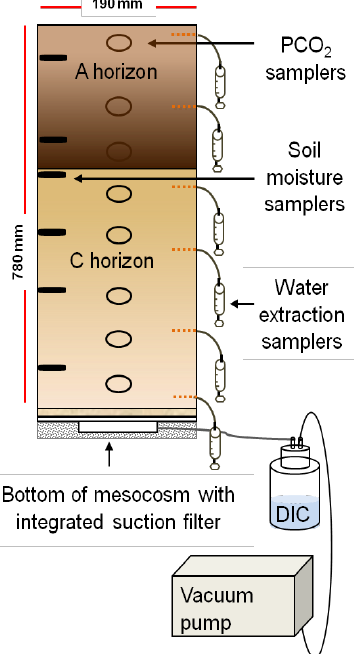
Fig. 1. Sketch of mesocosm with integrated sampling equipment and collection system for DIC at the bottom.